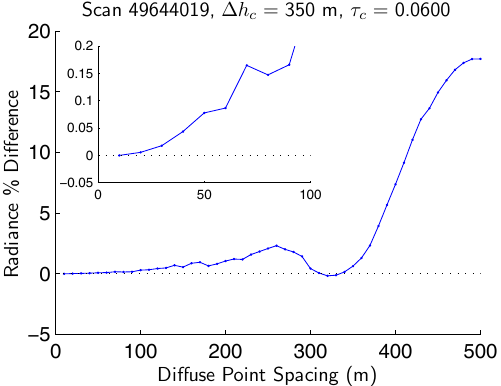
Fig. 4. Normalized modeled 750nm limb radiance at 15.8km tan- Fig. 4: Normalized modeled 750 nm limb radiance at gent altitude as a function of diffuse point altitude 15.8 km tangent altitude as a function of diffuse point alti- tude spacing. Table 1: Diffuse profile locations for studying effect of dif- fuse profile spacing.